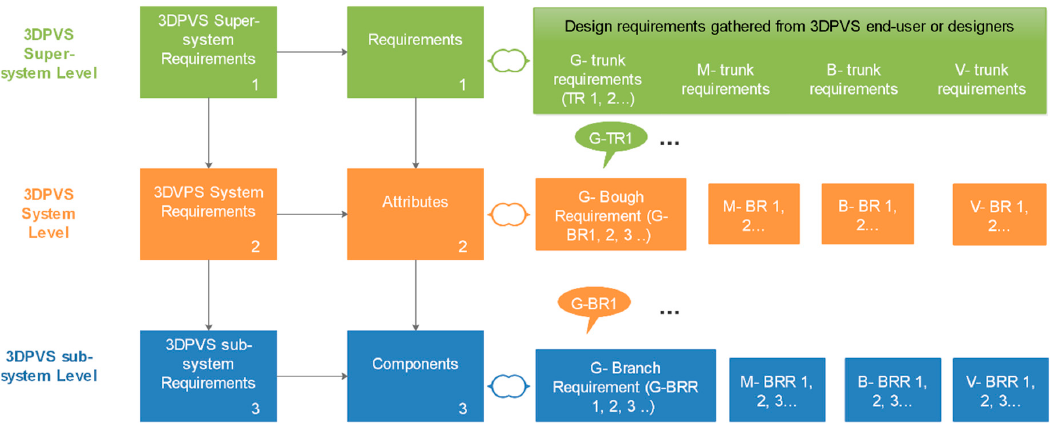
Figure 2. Illustration of the three-level requirements in 3DPVS design, namely ‘requirements’, ‘attributes’, and ‘components’. G: geometric, M: mechanical, B: biological, and V: vibratory.